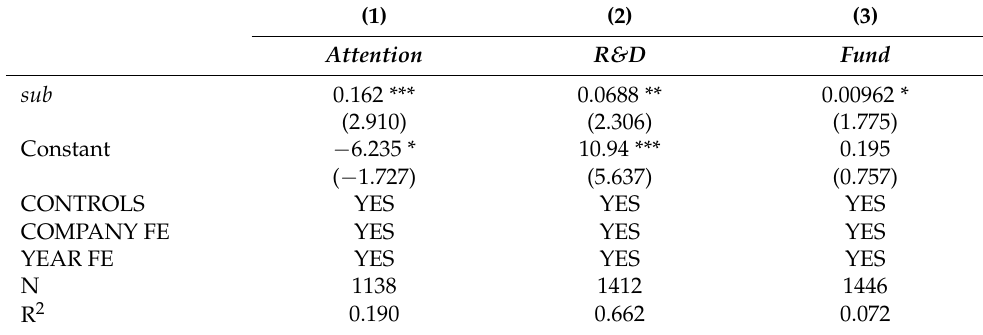
Table 10. Mechanism